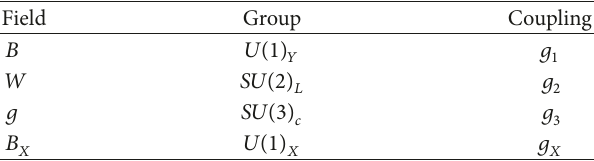
Table 1: Gauge sector of the model of [2].